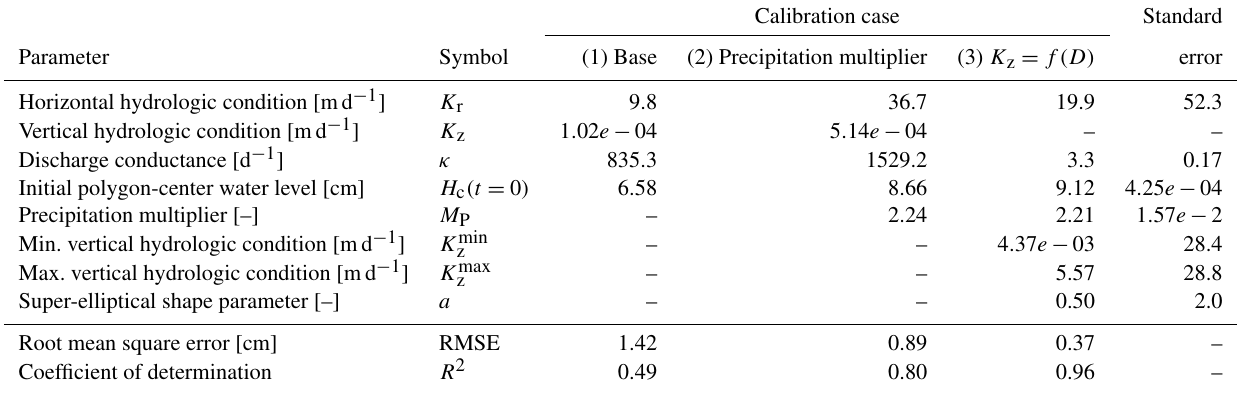
Table 1. Calibrated parameters values, root mean square error (RMSE), coefficient of determination ( R 2 ) for calibration cases, and parameter standard errors for case (3). Note that the coefficient of determination is equivalent to the Nash–Sutcliffe efficiency here. Dashes indicate that the parameter was not part of the